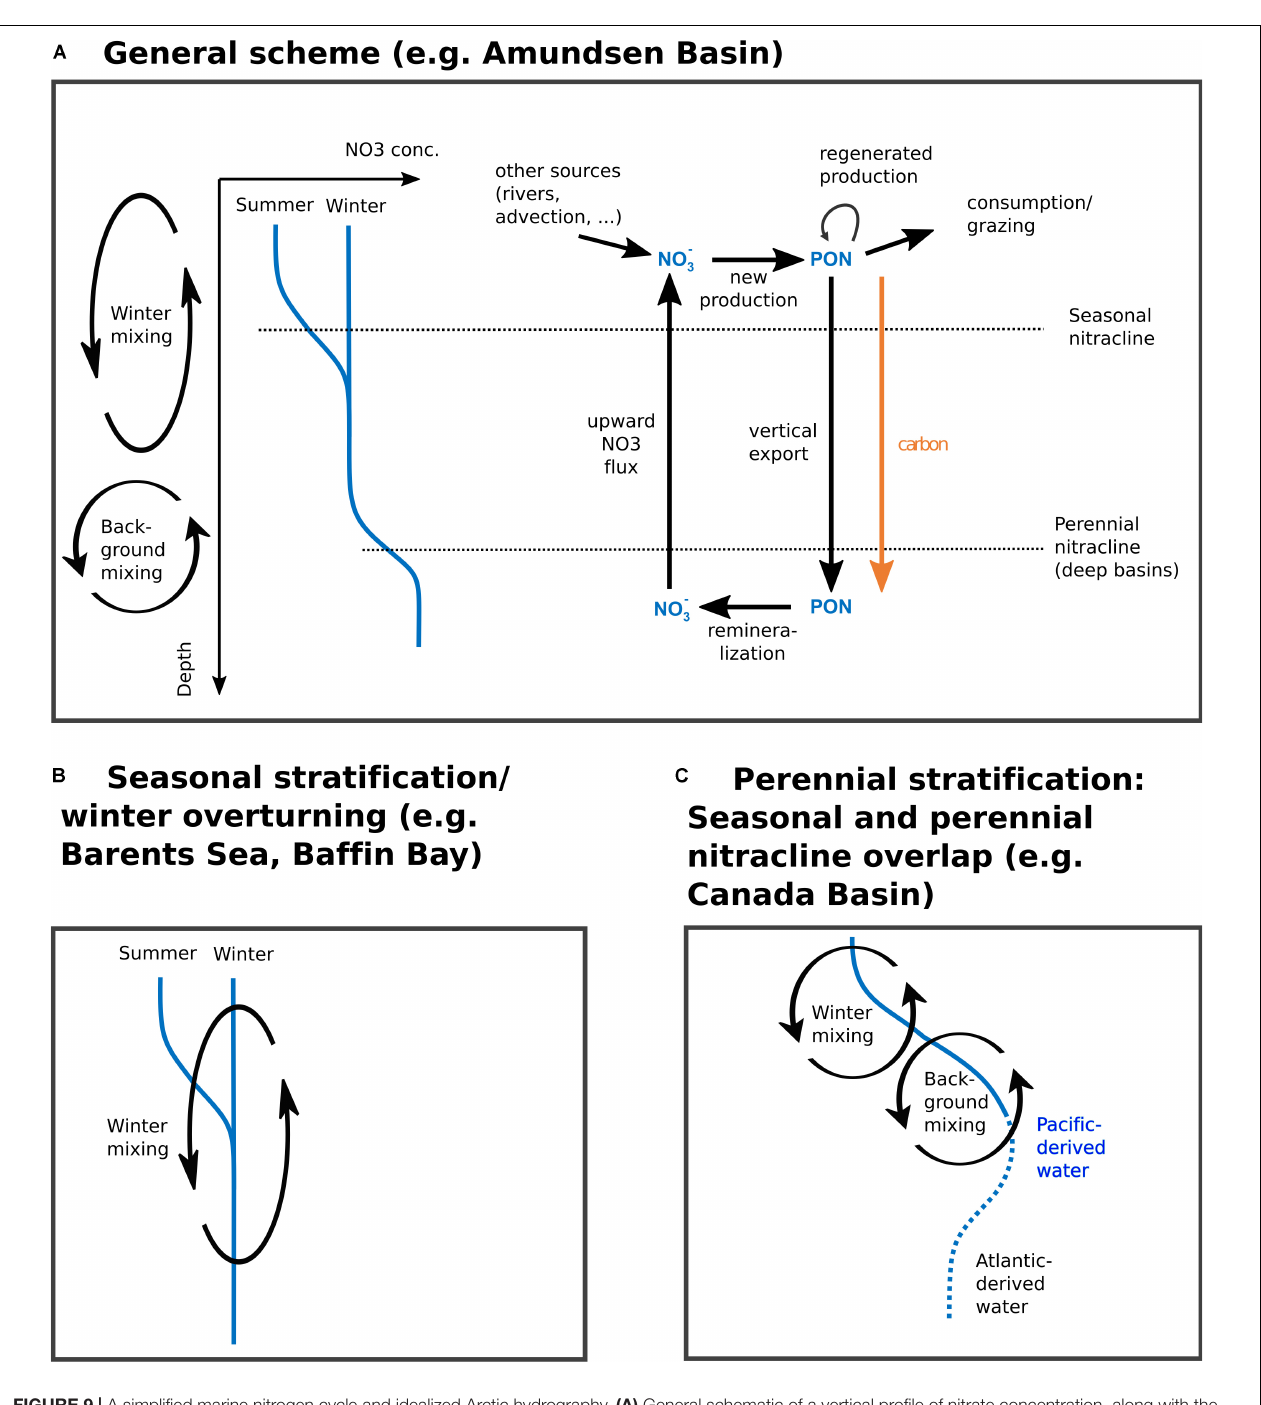
FIGURE 9 | A simplified marine nitrogen cycle and idealized Arctic hydrography. (A) General schematic of a vertical profile of nitrate concentration, along with the respective portion of the nitrogen cycle that takes place in each layer. In this idealized case, there is a clear separation between the seasonal variations in nitrate concentrations in the surface layer which give rise to the seasonal nitracline, and the underlying perennial nitracline. (B) In areas with deep overturning into the waters of maximum nitrate concentration, the deep nitracline ceases to be meaningful. Instead, nitrate fluxes tap into high-nutrient water every winter. (C) Highly stratified areas do not see large seasonal excursions in surface layer nitrate concentrations or mixing